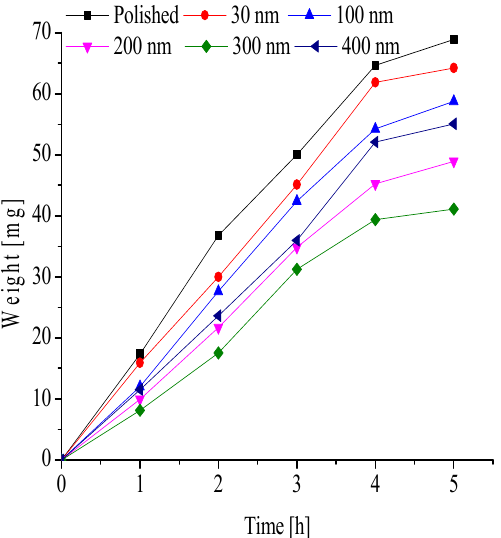
Figure 13. Variations of frost weight with different nanoporous diameters at T = − 20 °C, φ = 60%.